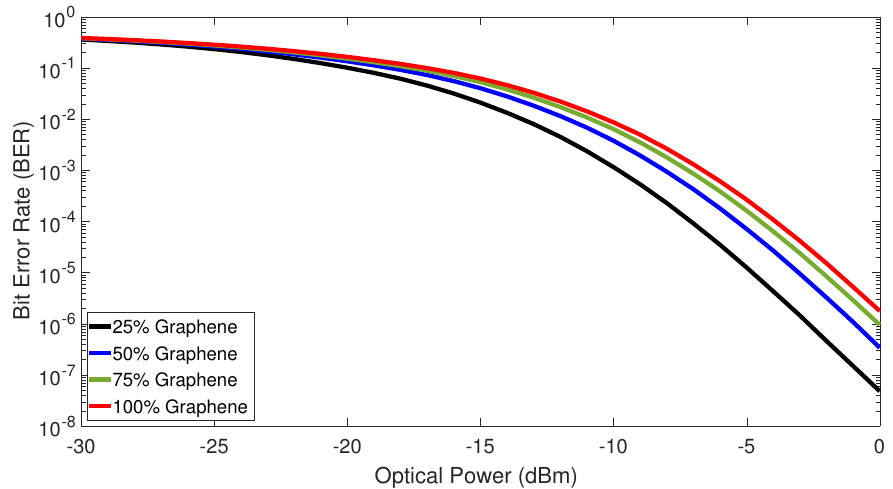
Figure 7. Bit error rate versus the optical power received in the photodetector for different amounts of graphene in the modulator.